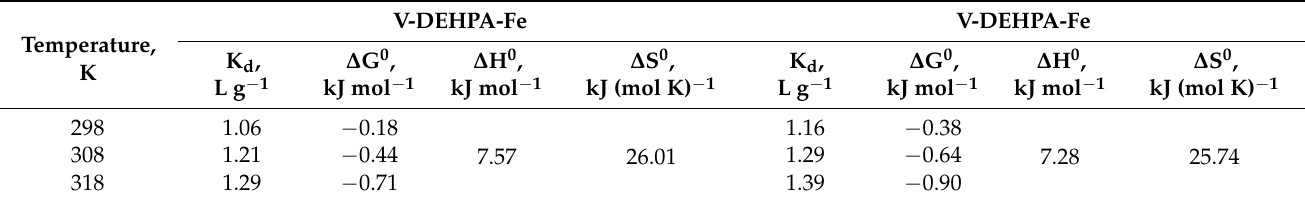
Table 3. Thermodynamic parameters for the adsorption of As(V) onto the functionalized materials. Temperature,